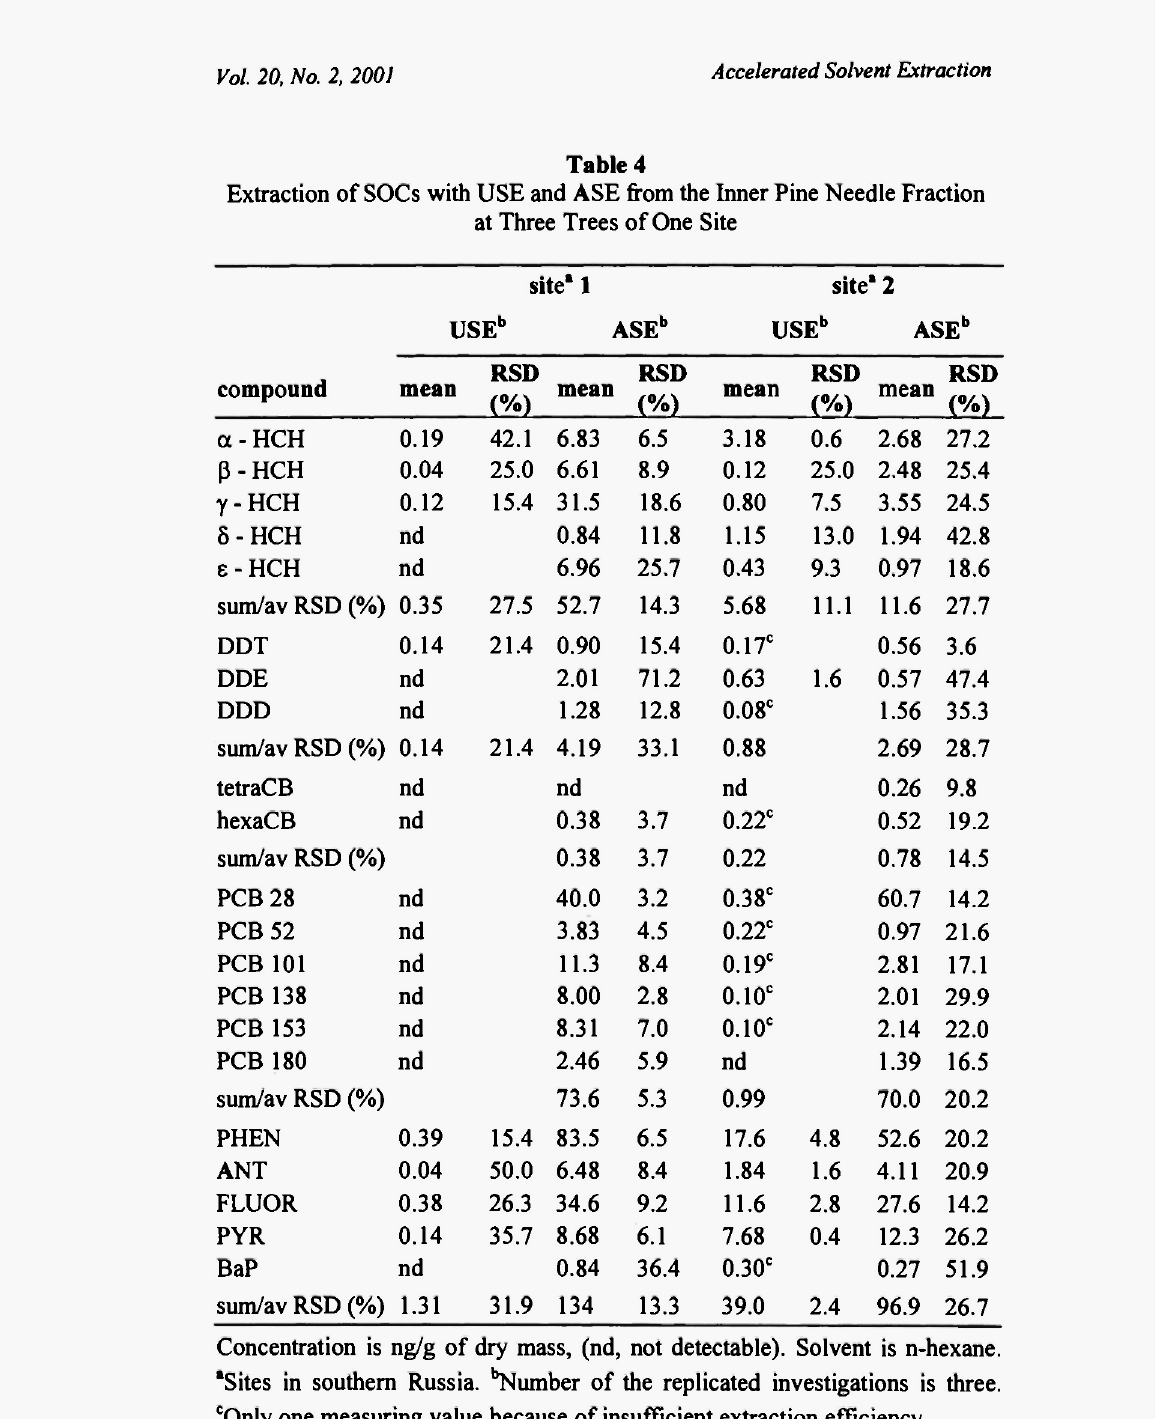
Extraction of SOCs with USE and ASE from the Inner Pine Needle Fraction at Three Trees of One